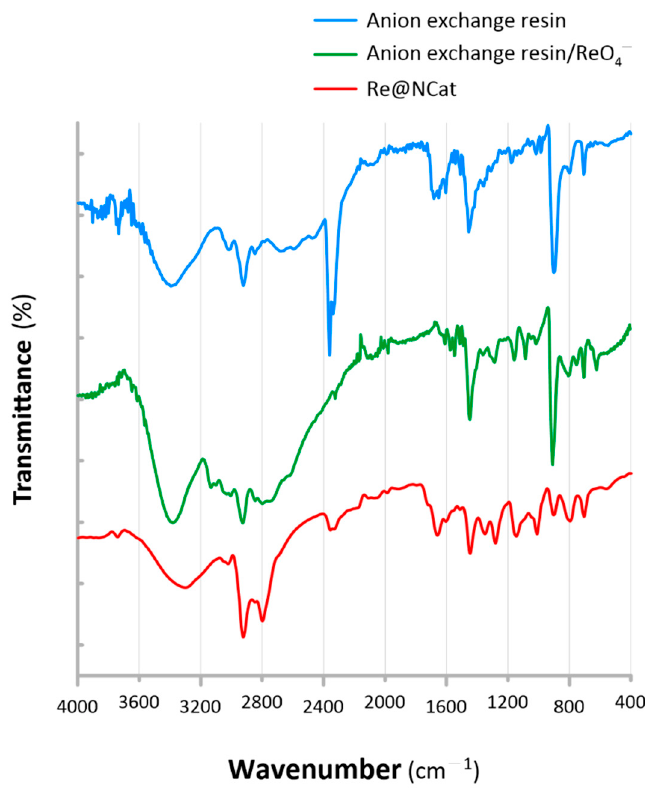
Figure 2. ATR FT-IR spectra recorded for the anion exchange resin (CIM-functionalized VBC-co-DVB copolymer), the ReO 4– loaded anion exchange resin, and the resultant Re@NCat.